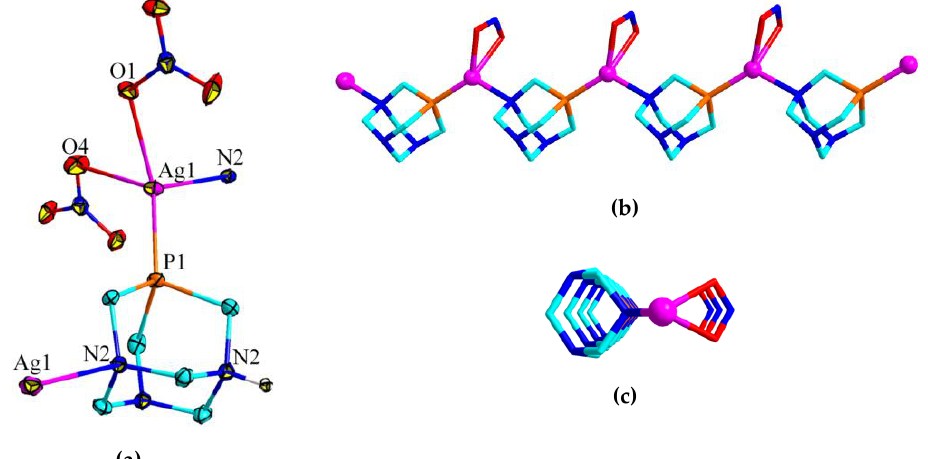
Figure 2. Structural fragments of 2 . ( a ) Elipsoid plot (50% probability). ( b , c ) Front (b) and side (c) views of 1D PTA-driven coordination chain; Ag (magenta balls), C (cyan), P (orange), N (blue), O (red).